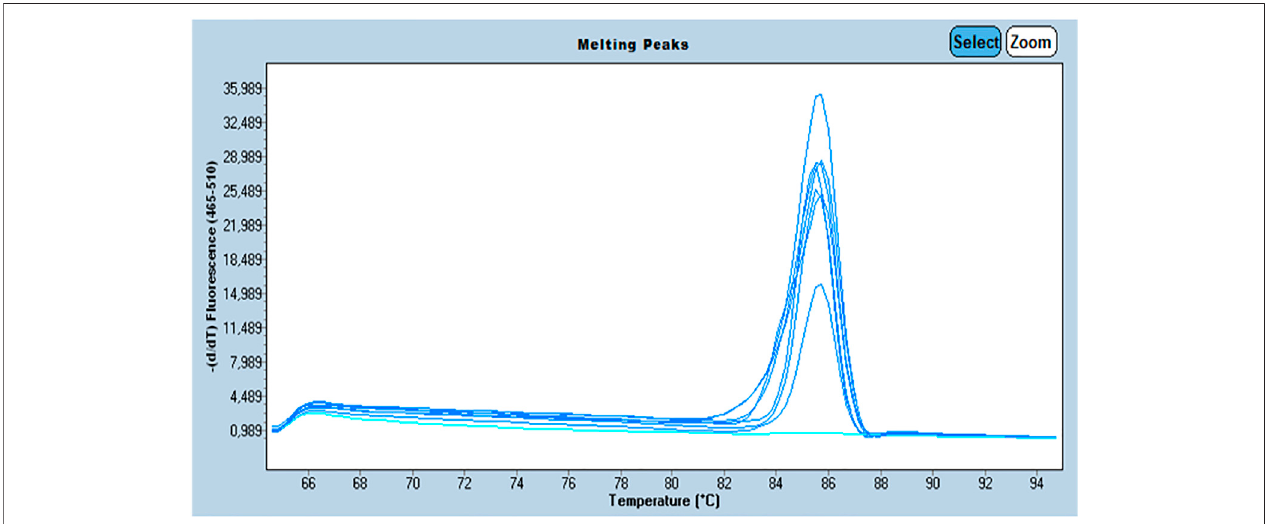
FIGURE1| Pro fi le ofthemelting peaks generated bytheampli fi cation β -Globin genebyQ-PCR with: Thecurves in dark blue arethesamplespositivefor β -Globin gene and the curves in light blue are the samples negative for β -Globin gene.